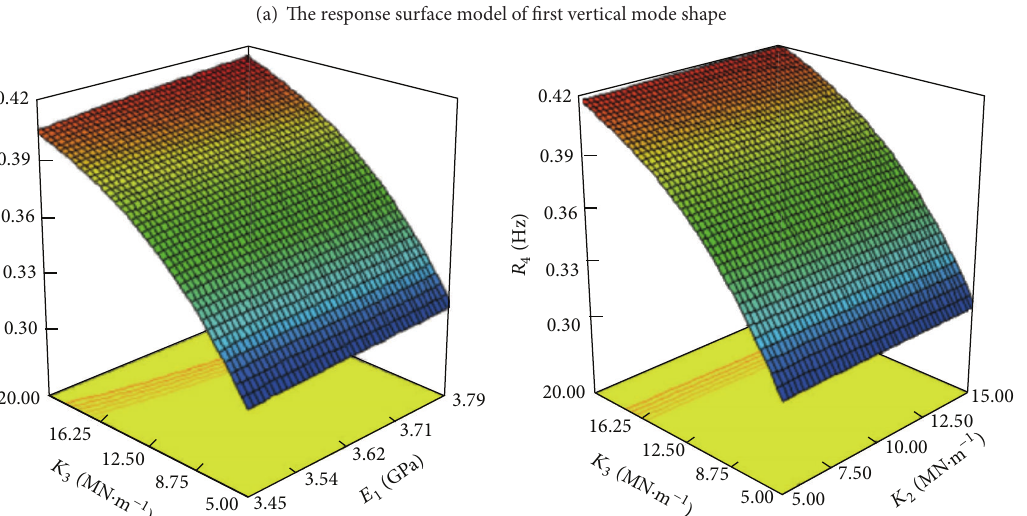
(a) The response surface model of first vertical mode shape